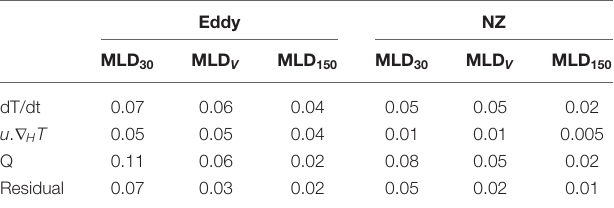
TABLE 1 | Standard deviations ( ◦ Cday − 1 ) of the heat budget terms calculated in each of the three SML depth scenarios in the Eddy and NZ regions. Eddy NZ MLD 30 MLD V MLD 150 MLD 30 MLD V MLD